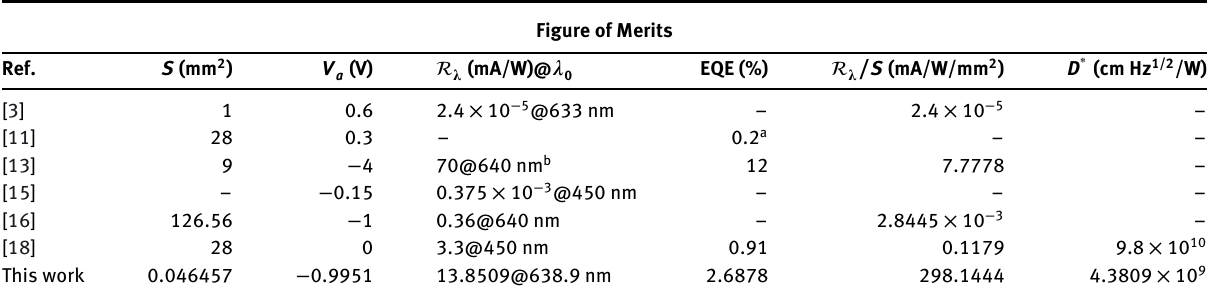
Table 4: Comparisons of recently reported hot-electron-based PDs operating in visible frequencies ( S : active area, V a : applied voltage,  𝜆 : responsivity, 𝜆 0 : free-space wavelength,  𝜆 ∕ S : per-unit-area responsivity, D ∗ : detectivity).